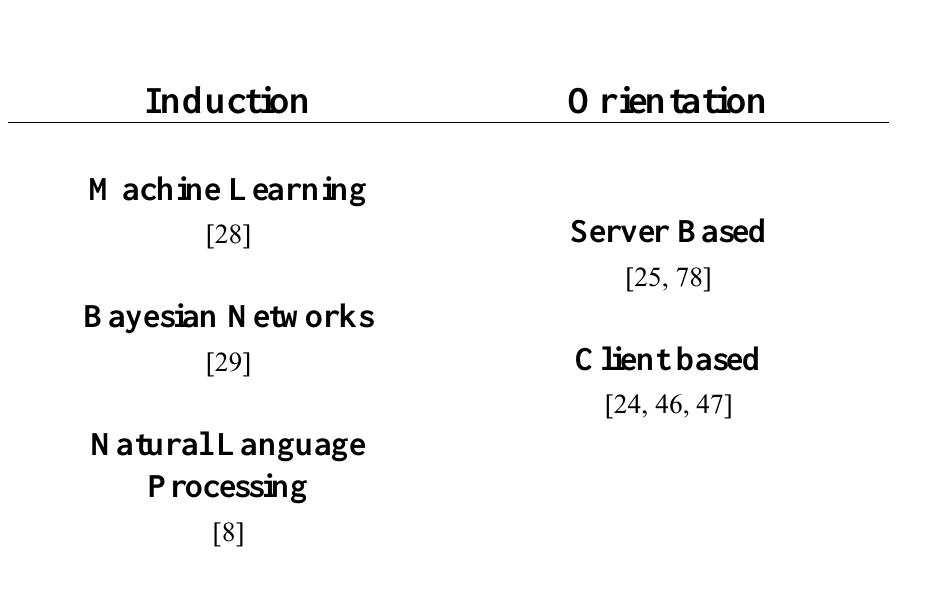
Table 4. Mashup Agent